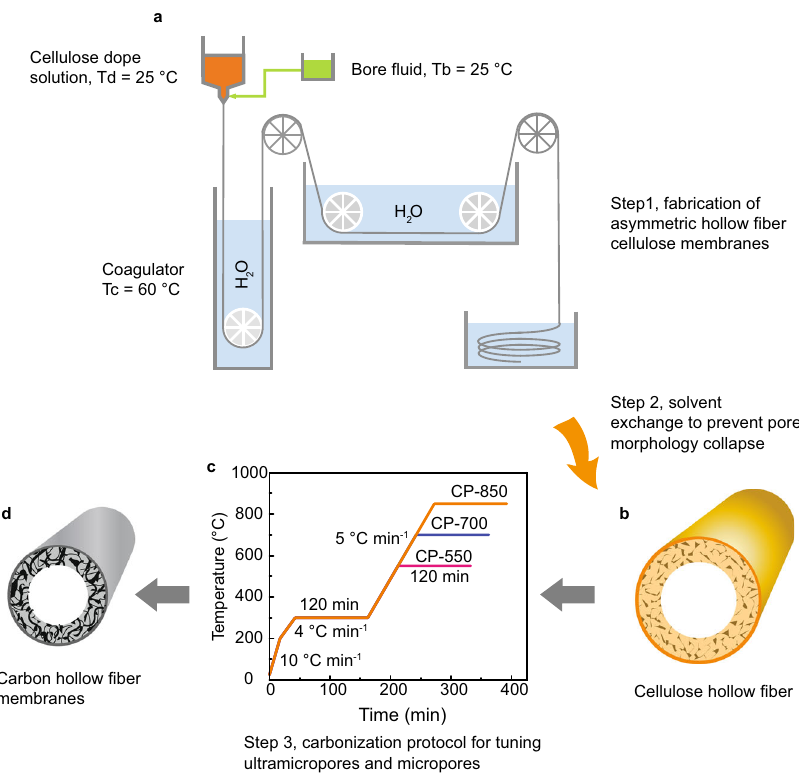
Fig. 1 Preparation of carbon hollow fi ber membranes (CHFMs). a Schematic of the fabrication process for asymmetric cellulose hollow fi bers by the dry- wet spinning process with controlled spinning temperatures. Temperature of dope solution (Td), bore solution (Tb), and coagulator (Tc) are 25, 25, and 60 °C, respectively. b Schematic of dried cellulose hollow fi ber precursors. c Carbonization protocols (CPs) for the fabrication of CHFMs. d Schematic of asymmetric CHFMs. The key step 1 is the fabrication of asymmetric cellulose hollow fi bers by controlling the coagulation temperature at >45 °C (60 °C was used in this work); step 2 is non-solvent exchange using lower surface tension solvents (isopropanol, n -hexane) to remove residual water inside hollow fi bers before drying to prevent pore morphology collapse; step 3 is tuning the ultramicropore and micropore structure of carbon membranes by changing the fi nal carbonization temperature from 550 to 850